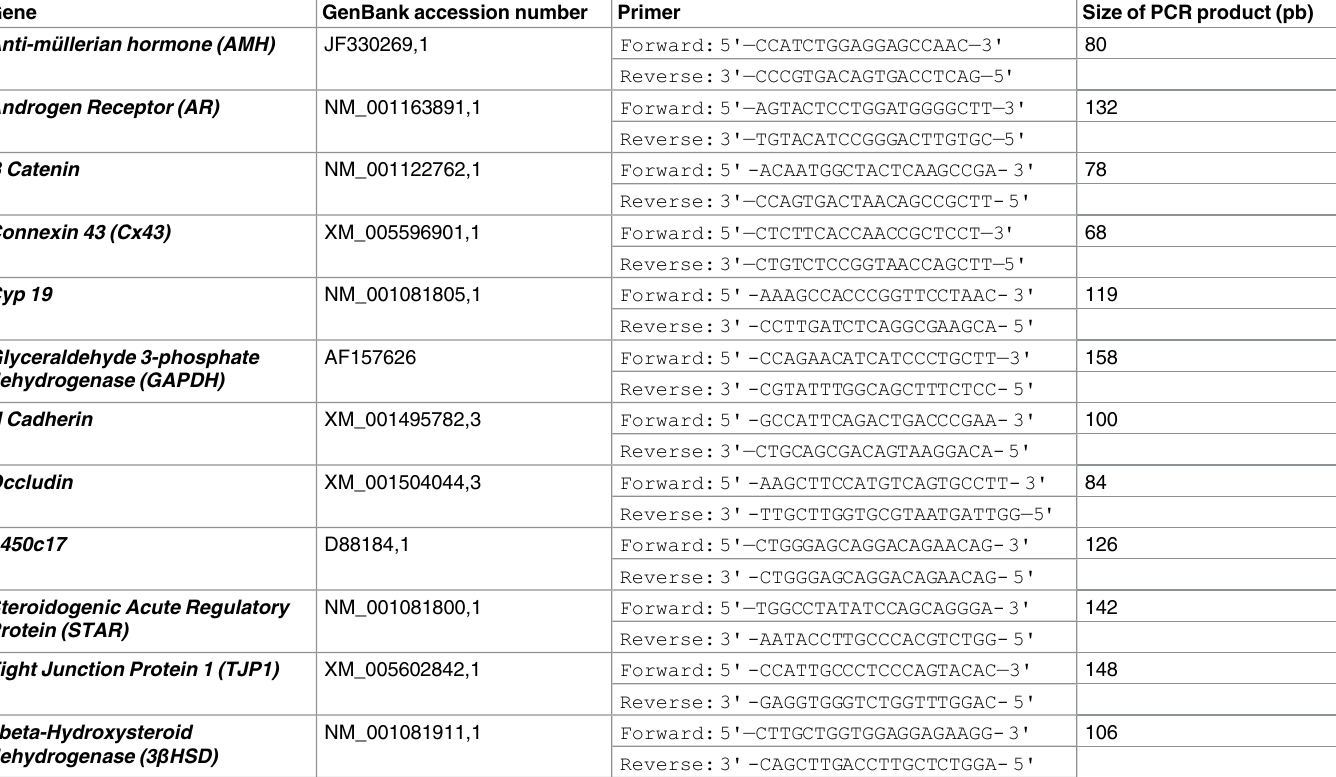
Table 4. Primers sequences used for amplification of equine products in RT-qPCR assaysin testicles of prepubertal